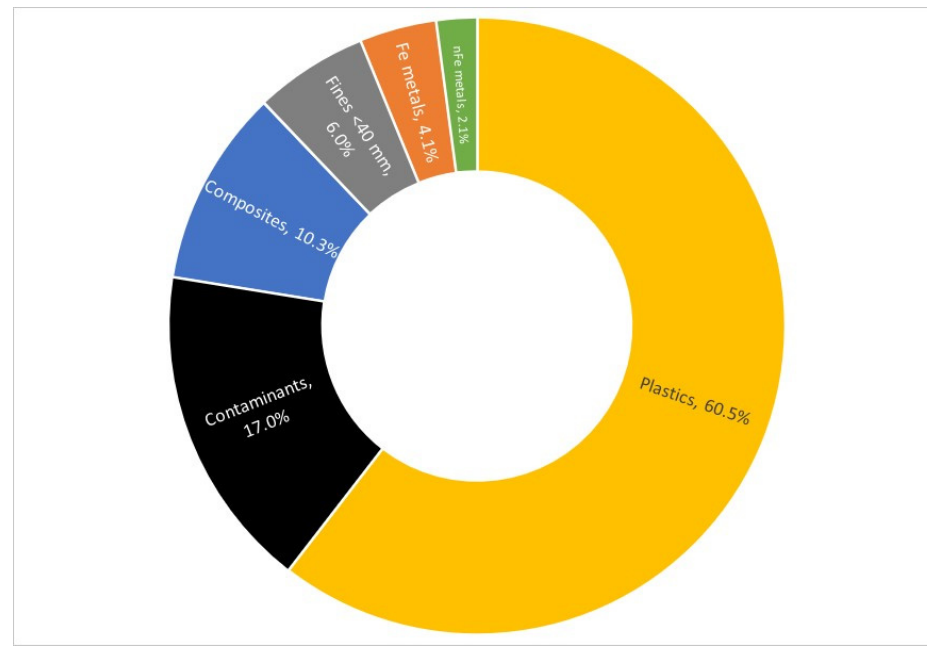
Figure 3. Composition of separately collected light recyclables—main categories.